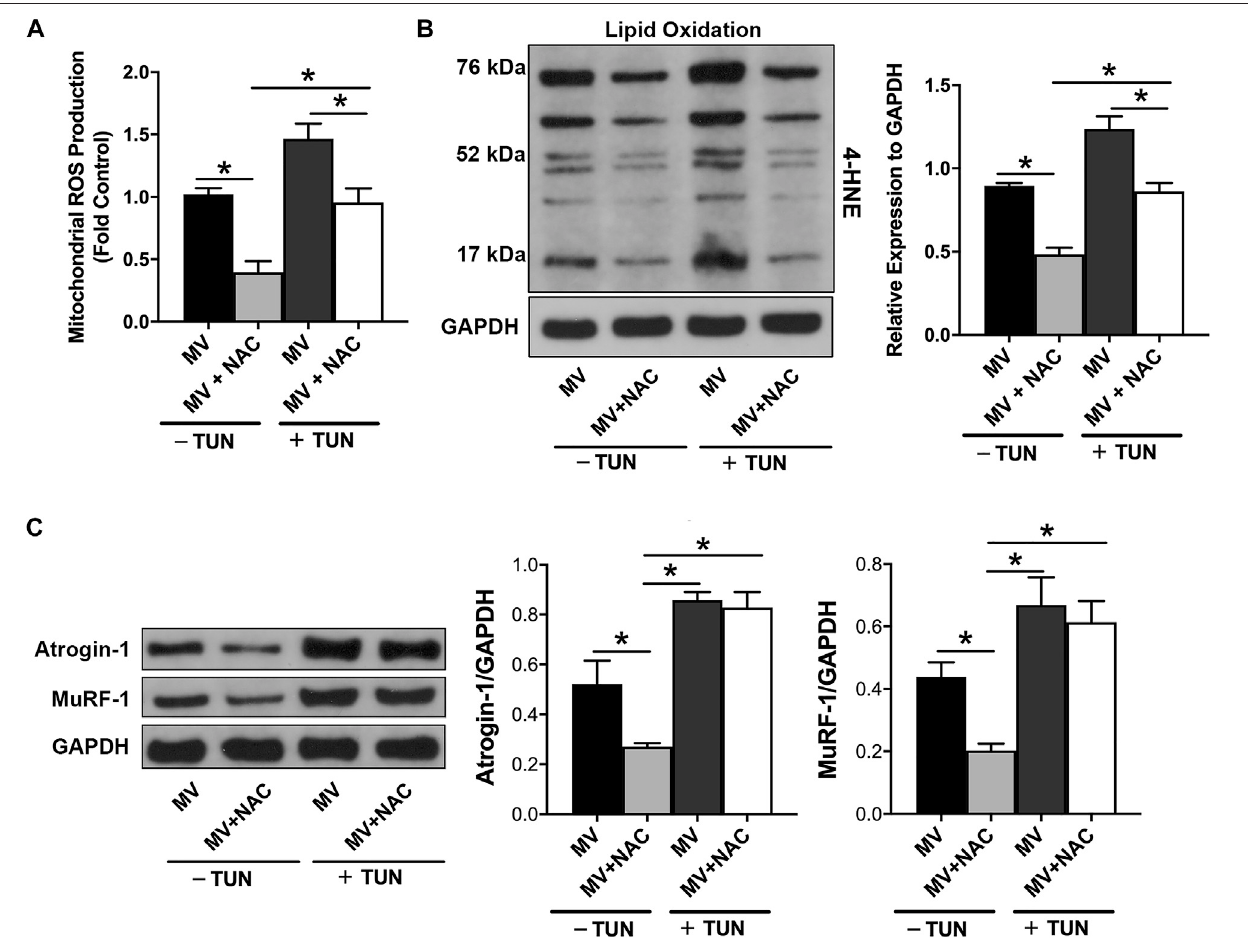
FIGURE 6 | ER stress induces diaphragmatic proteolysis in the absence of oxidative stress during MV. The detection of mitochondrial ROS production (A) and analysis of lipid oxidation (B) showed that NAC reduced oxidative stress in rats undergoing MV in the absence and presence of TUN. (C) Analysis of the protein expression of Atrogin-1 and MuRF-1 suggested that induction of ER stress by TUN enhanced protein degradation in the presence and absence of NAC. * p < 0.001 (ANOVA followed by the Tukey HSD test, n = 6 per group). ROS = reactive oxygen species, NAC = N-acetylcysteine, MV = mechanical ventilation, TUN = tunicamycin, 4-HNE =